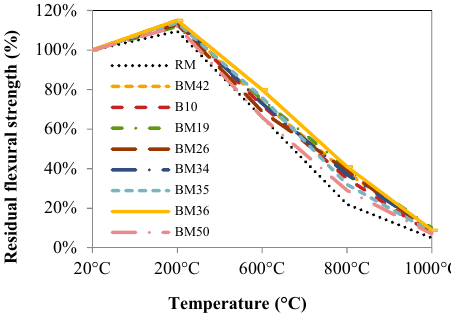
Figure 12. Residual compressive strengths.